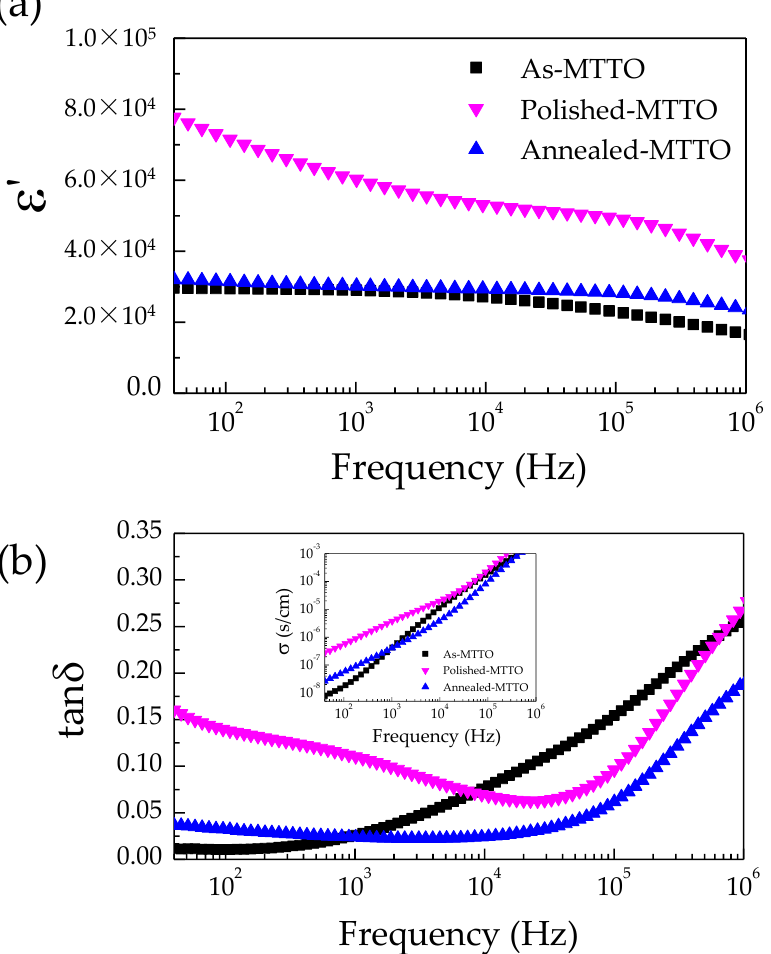
Figure 3. Frequency dependence of ( a ) ε′ and ( b ) tan δ at RT in as-MTTO, polished MTTO, and annealed MTTO ceramics. The inset of ( b ) shows the conductivity at RT in the frequency range of 40–10 6 Hz.